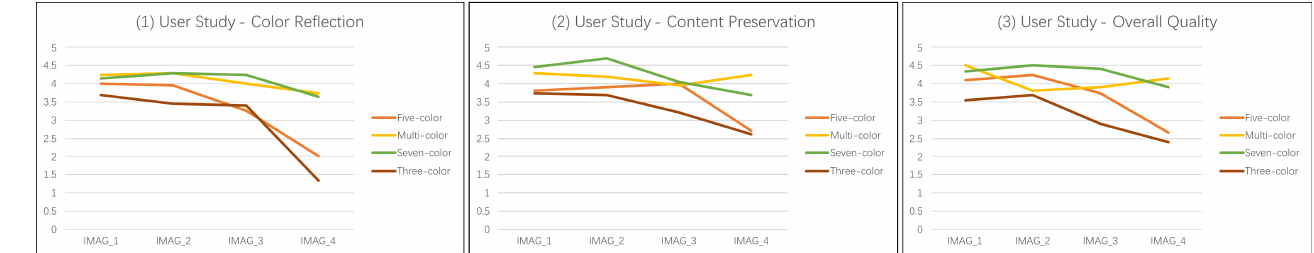
Figure 8. The first user study. Each participant is asked to answer three aspects: color reflection, content preservation, and overall